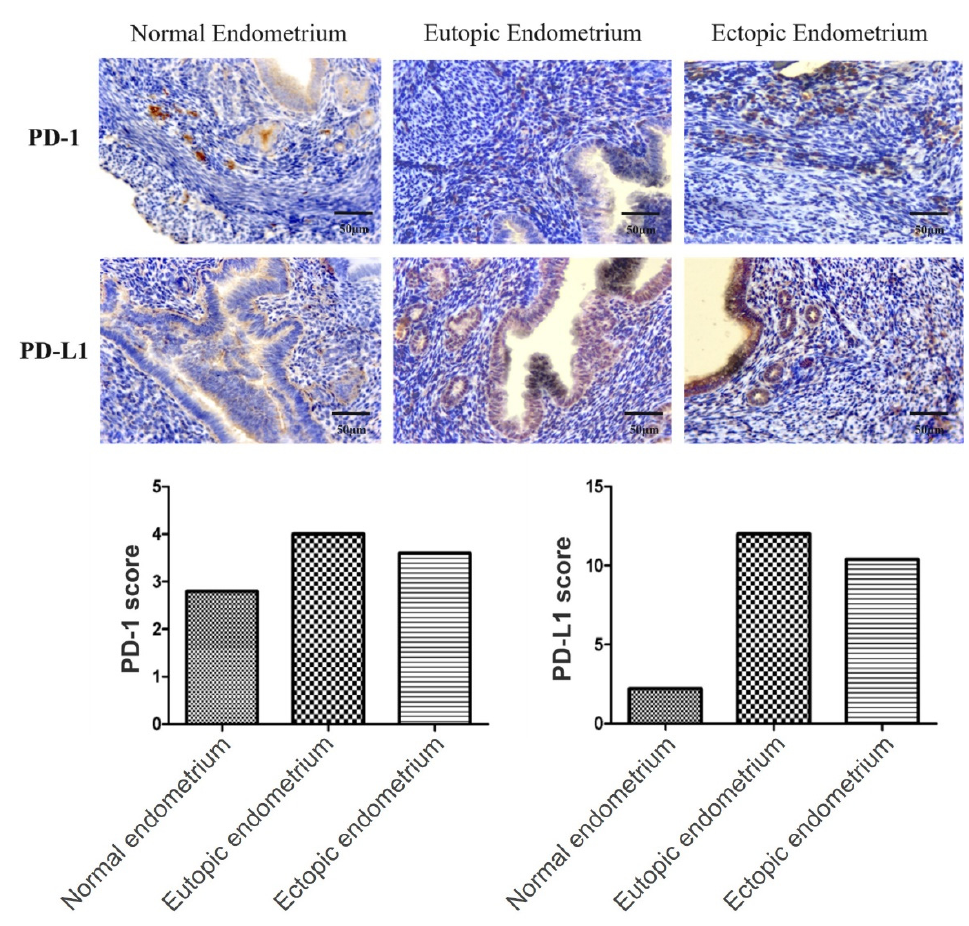
Figure 3. An example of overexpression of PD-L1 in endometriosis. Immunohistochemistry of PD-1 and PD-L1 in the eutopic endometrium and ectopic endometrium (endometriotic lesions) of an endometriosis patient and in the endometrium of a healthy woman is shown. The immunoreactive scoring, in which a product of the IHC staining intensity (0–3) and the percentage of positively stained cells (0, 0%; 1, 1–10%; 2, 11–50%; 3, 51–80%, and 4, ≥ 80%) was calculated, are shown in the lower panel.